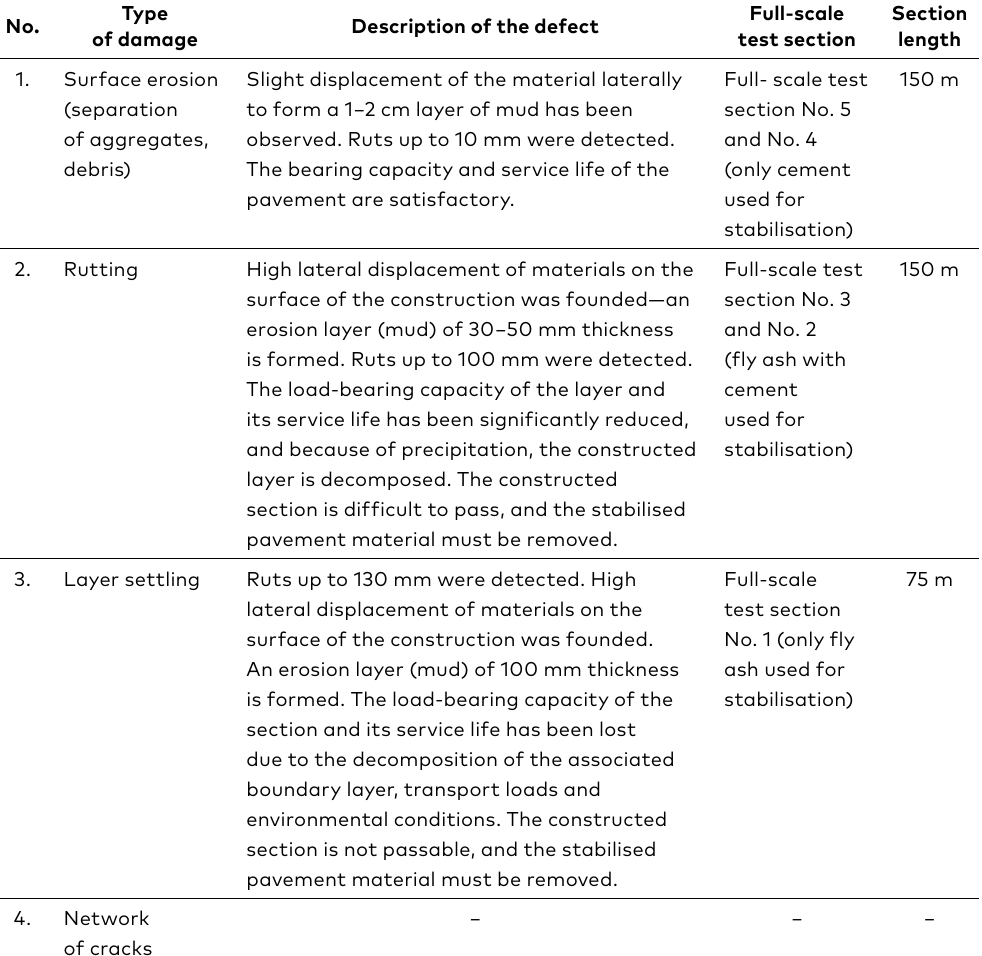
Table 5. Summary of detected defects